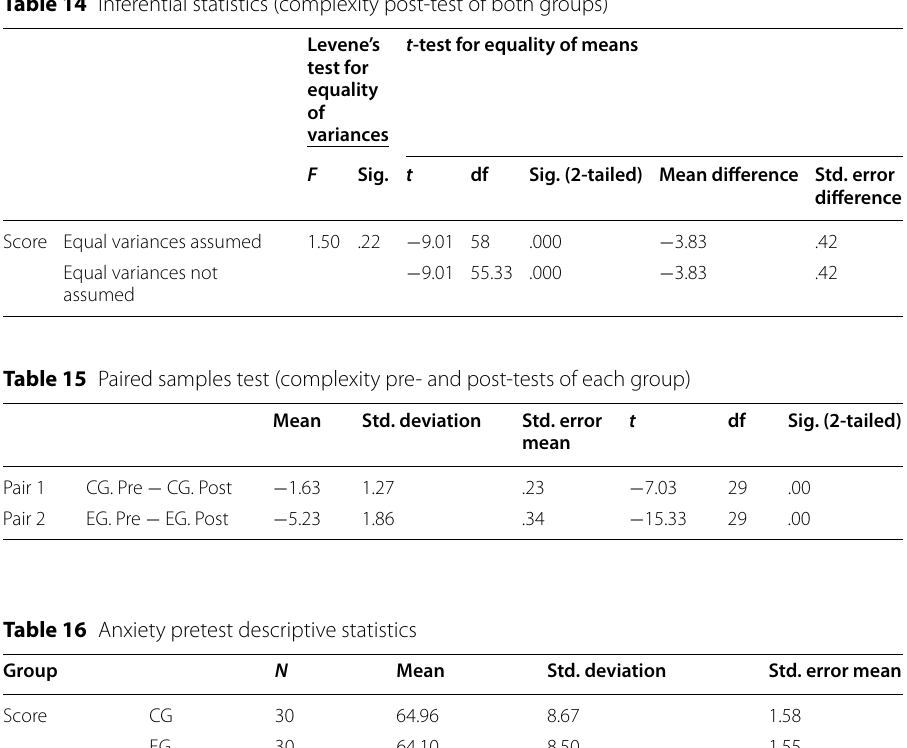
Table 14 Inferential statistics (complexity post‑test of both groups)